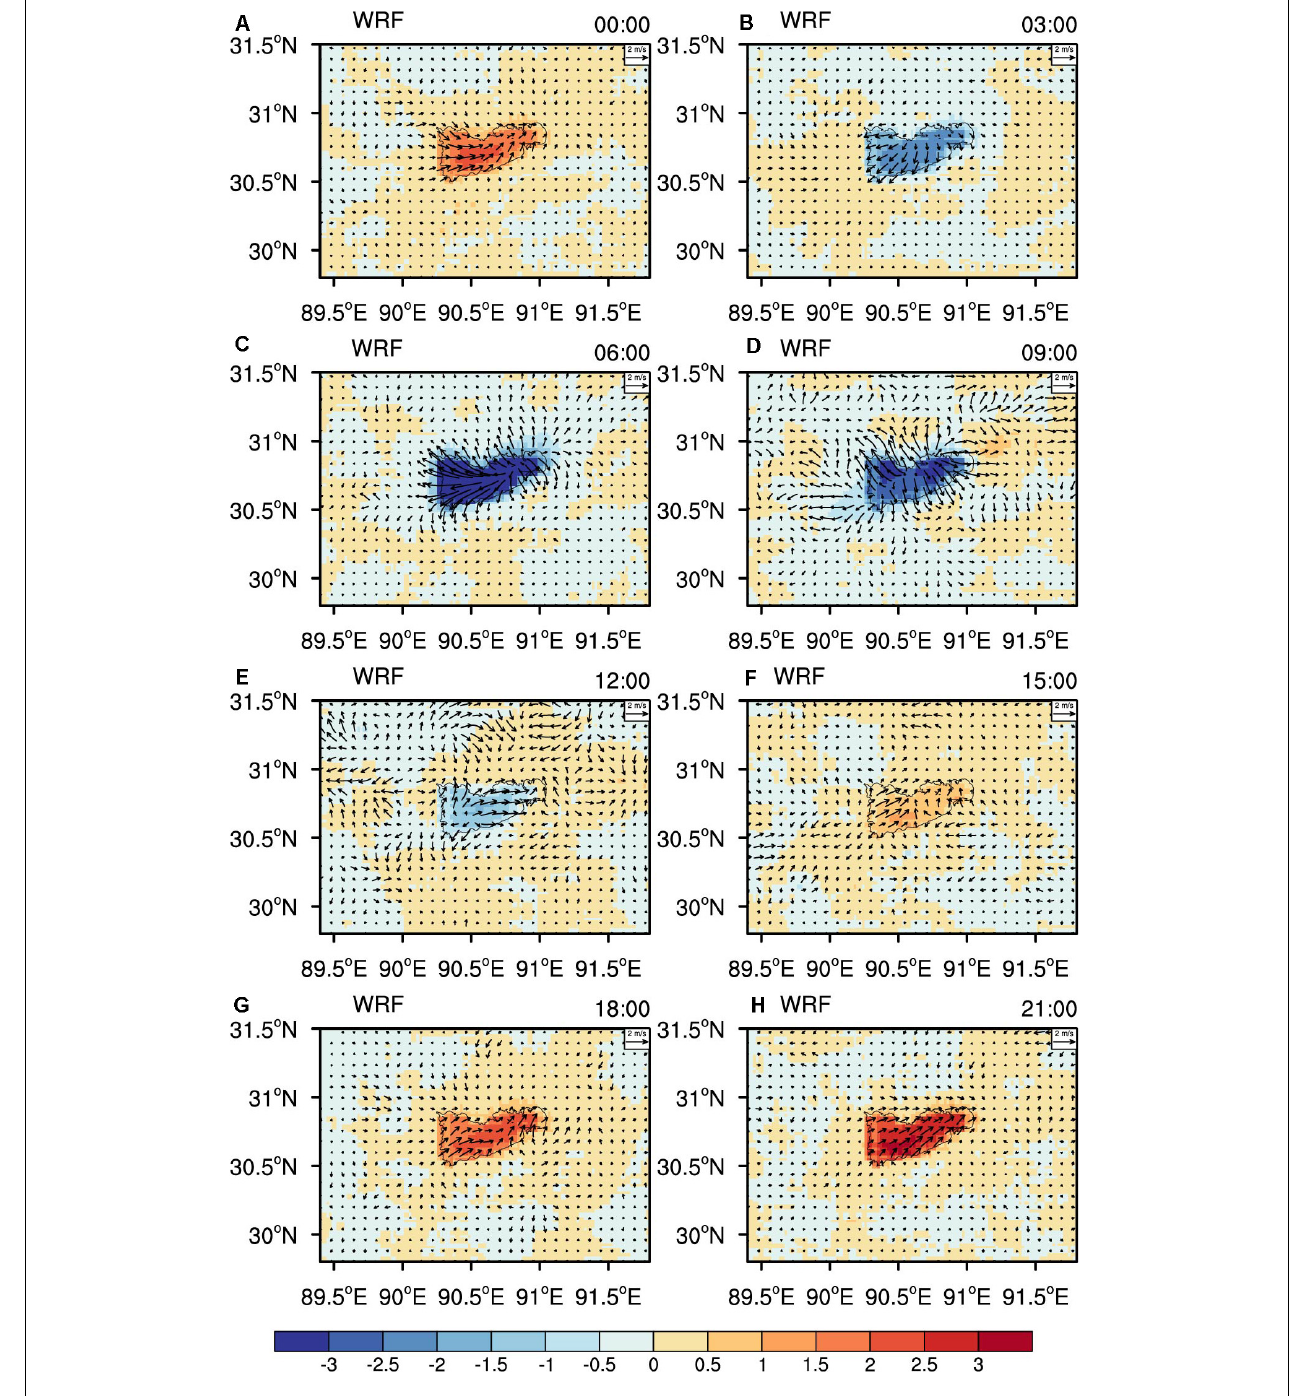
FIGURE 9 | Spatial pattern of simulated of monthly mean 3-h 2 m air temperature ( A–H , shading, units: ◦ C) and 10 m wind ( A–H , vector, units: m/s) anomaly (difference between WRF_lake and WRF_nolake simulations) in July 2008.